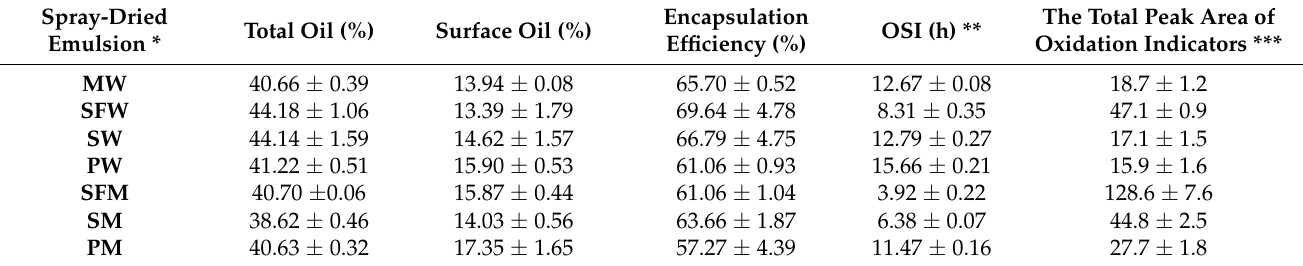
Table 1. Total and surface oil content, encapsulation efficiency, oxidative stability index, and total peak area of selected volatile oxidation indicators of spray-dried emulsions.